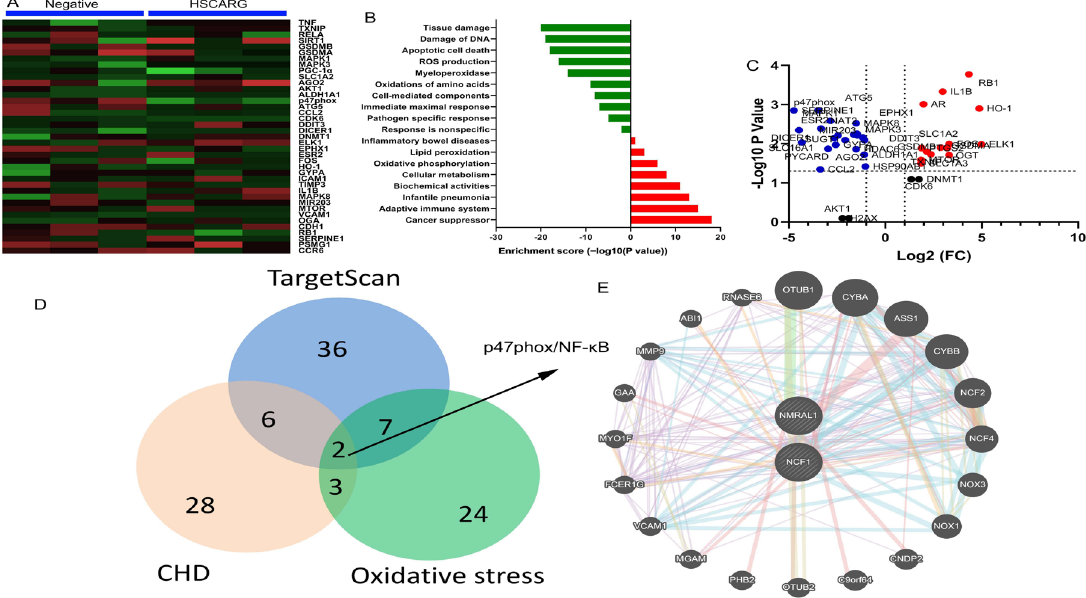
Fig. 4 - p47phox is an important target for HSCARG. Heat map and microarray data (A and B), volcanoes map (C), interpretation of result (D), network signal map (E). CHD=coronary heart disease; DNA=deoxyribonucleic acid; FC=fold change; NF-κB=nuclear factor kappa B; ROS=reactive oxygen